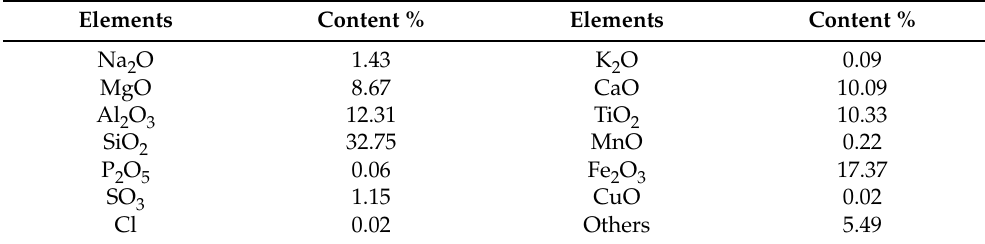
Table 1. Chemical multi-element analysis results of mineral samples.